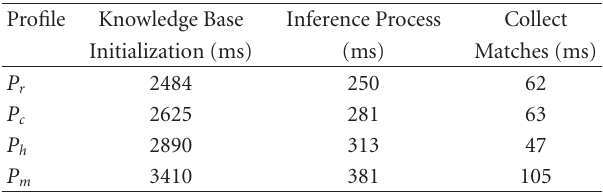
Table 4: Evaluation results of the system